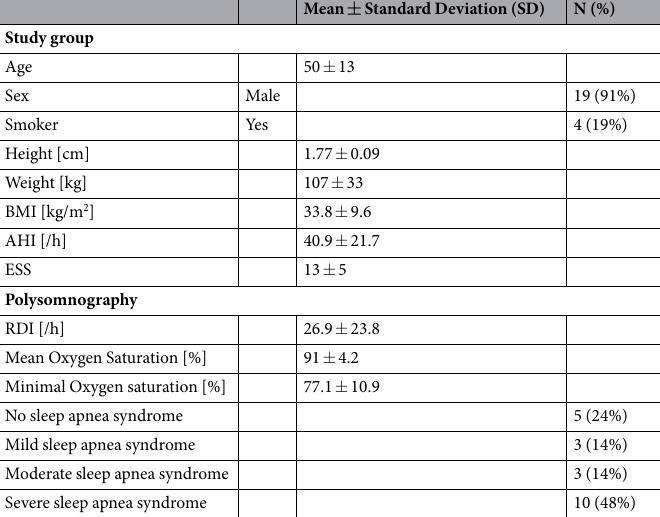
Table 1. Baseline data of the study